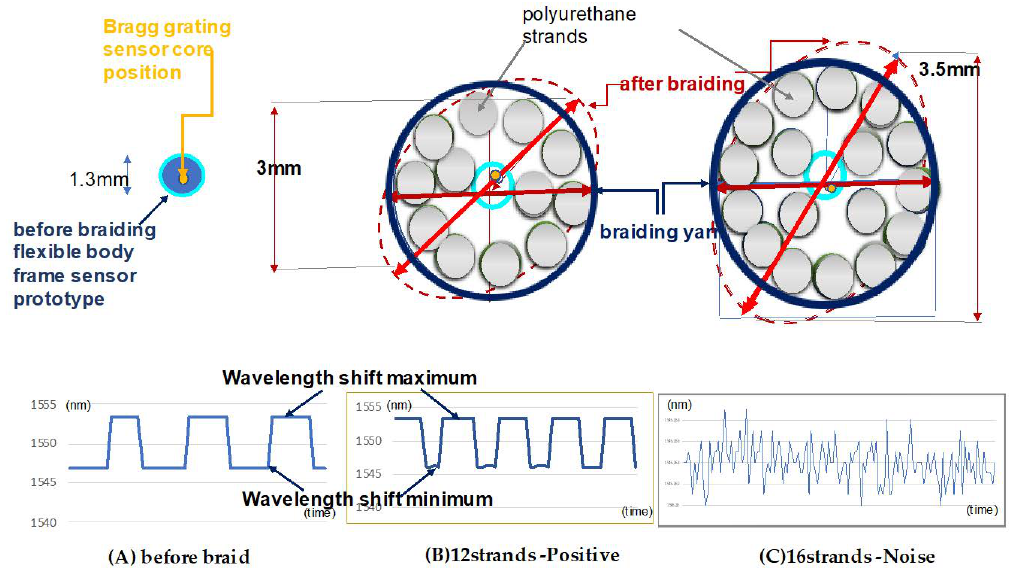
Figure 7. The wavelength variation for the change in the maximum and minimum values was measured; the morphology of the braid. Before the braid ( A ) and after the 12-strand braid ( B ) show the e ff ectiveness of the sensor ( C ). The noise signal in the 16-strands